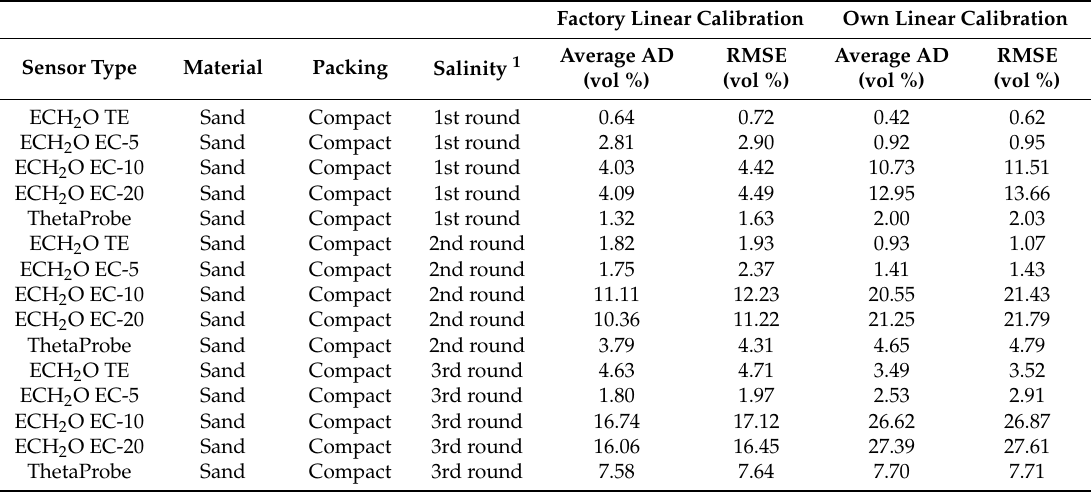
Table 8. Performance comparison of factory and our own linear calibrations for all five tested sensors in saline conditions: average AD (vol %) and RMSE values (vol